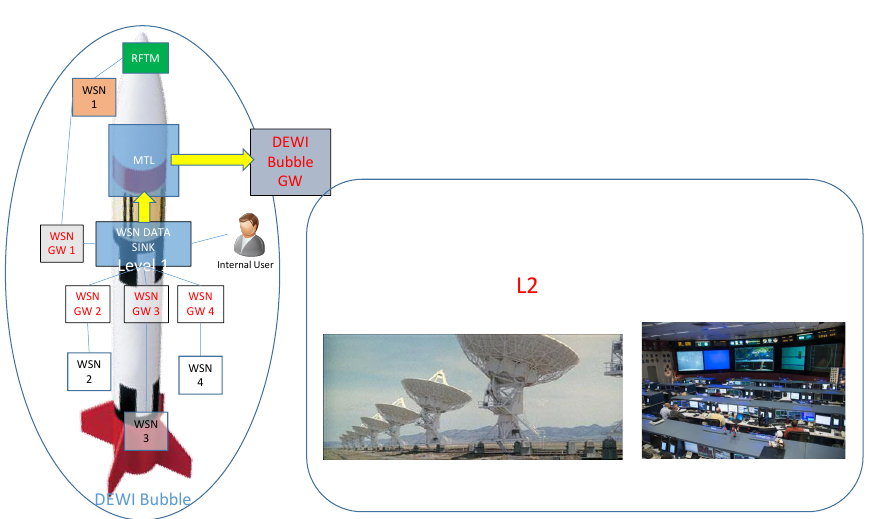
Figure 17. Mapping UC2.4 to the layered model of the DEWI HLA. Use case 2.5 (Figure 18) also belongs to the aerospace domain. A highly dense network of sensors over the surface of the plane is used to track variations of pressure associated with turbulent flow formation or degradation of laminar conditions. The information is used to activate a set of actuators based on flow injection. Sensors and actuators are arranged in patches, internally wired, but connected via wireless to a gateway and to the central coordinator of the system on board. The WSN is therefore connected to the internal bus of the aircraft. The bubble gateway relays information to ground control.